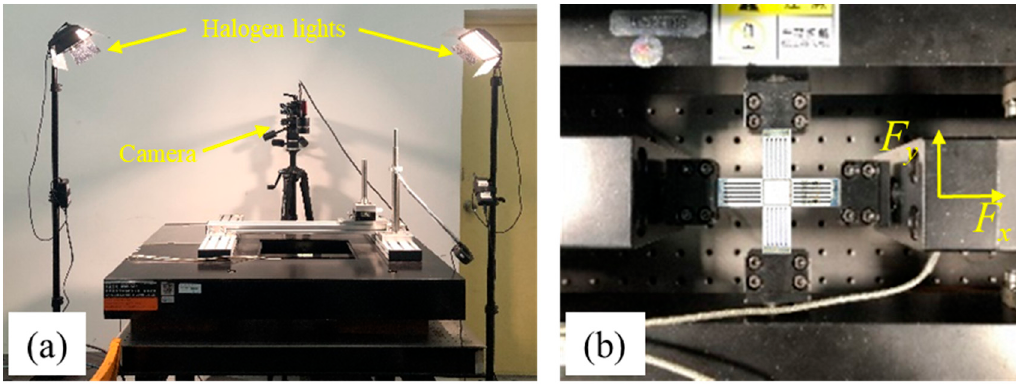
Figure 2. ( a ) DIC and biaxial tensile testing machine, ( b ) clamping device and speckle pattern (where F x represents load at rolling direction and F y represents load at transverse direction).